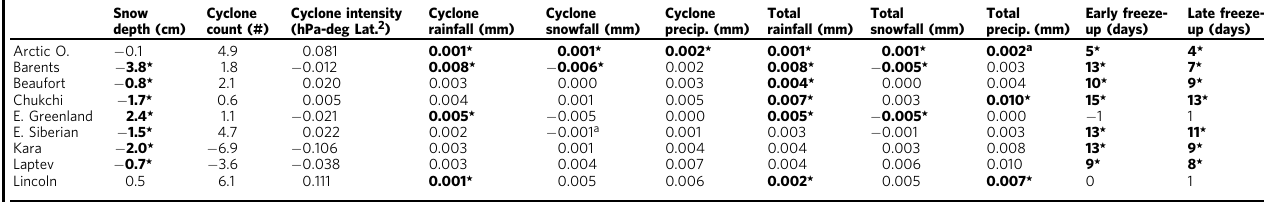
Bold text and asterisks indicate at least 95% statistical signi fi cance. Rainfall, snowfall, and precipitation amounts were normalized by the corresponding regional areas to allow inter-comparison across regions. Note, cyclone and precipitation variables were not normalized by the sea-ice area due to the negative trends in sea-ice extent. a